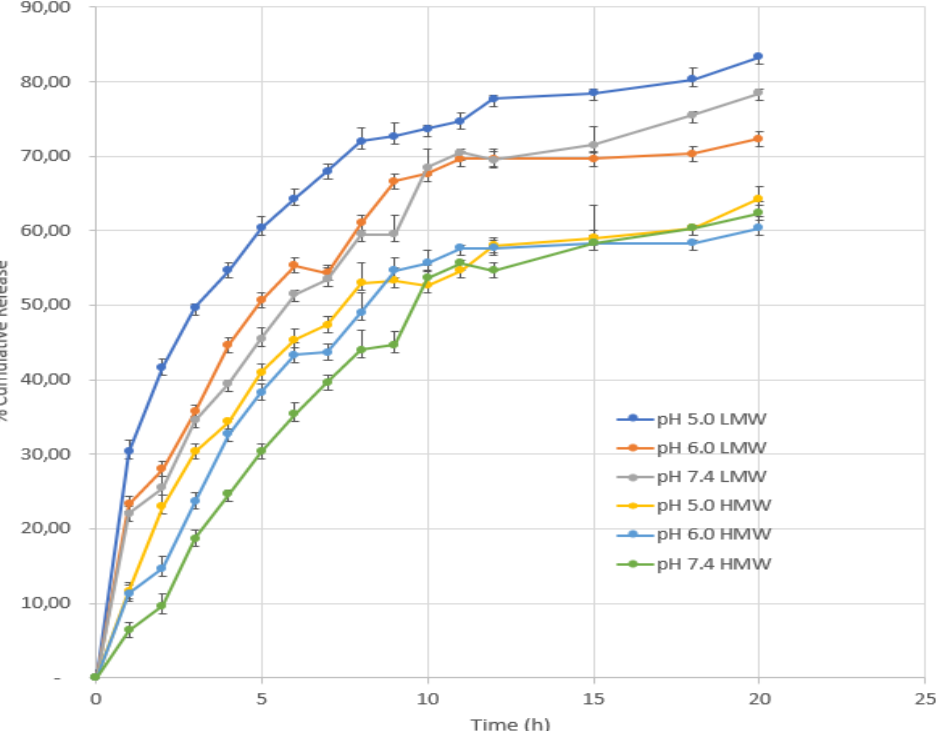
lower pH, releasing active substances into the medium. The positive surface of CSNPs at lower pH also reduced the drug–CSNP electrostatic interaction and promoted drug release. These data indicate the new DDS’s pH-triggered opioid releasing action. Most of the drug is expected to remain in the carrier for a long time (pH 7.4), reducing negative effects on normal tissues. However, once drug-loaded tumor cell CSNPs are endocytosed, the more rapid release may occur at lower local pH, at the tumor site, or within tumor cell endosomes and lysosomes, increasing the efficacy of cancer therapy. The pH of